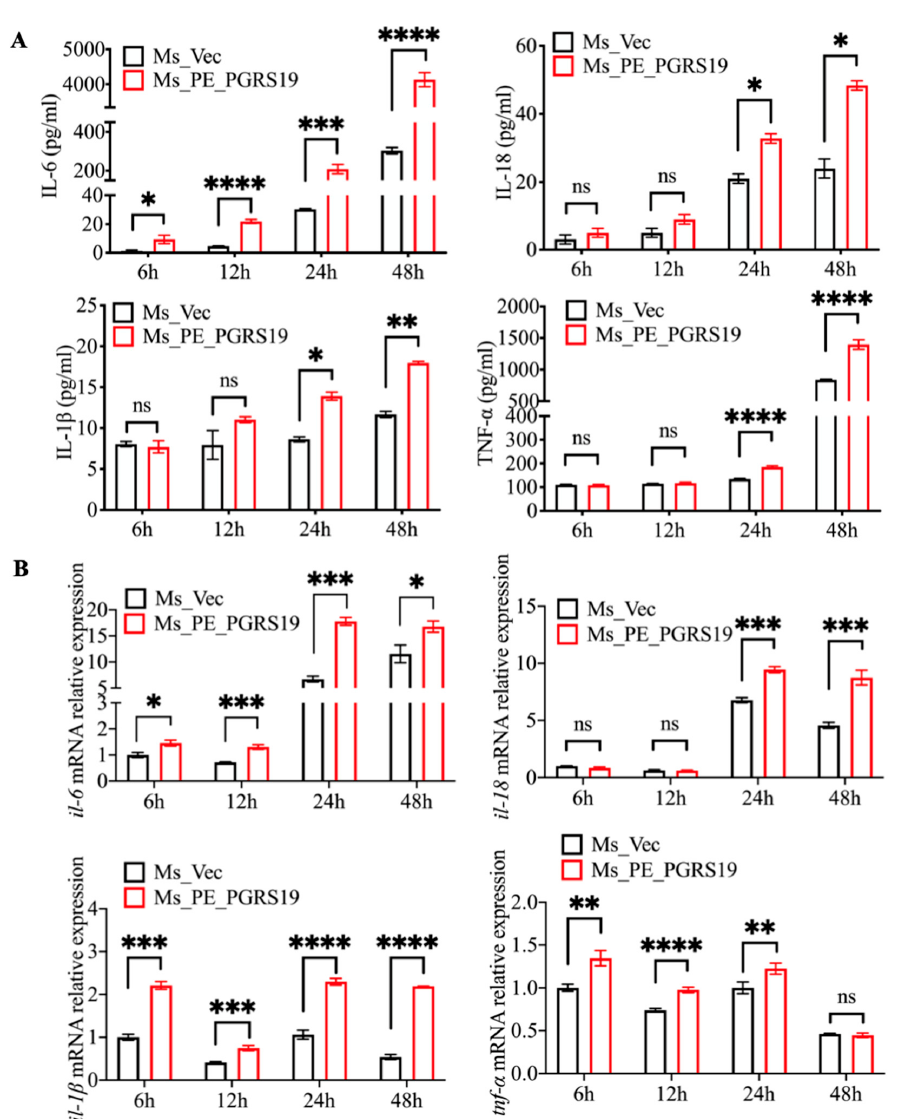
Figure 3. Cell cytokine expression and secretion in macrophages infected with the recombinant strains. Secretion ( A ) and mRNA relative expression ( B ) of TNF- α , IL-6, IL-1 β , and IL-18 were measured by ELISA assay and real-time PCR in Ms_PE_PGRS19- and Ms_Vec-infected J774A.1 cells at 6, 12, 24 and 48 h. Data are presented as x ̄ ± SD of three independent experiments. ns p > 0.05, * p < 0.05, ** p < 0.01, *** p < 0.001, **** p < 0.0001. 3.4. PE_PGRS19 Induces Cell Pyroptosis by Promoting the Cleavage of Caspase-11 and GSDMD Ms_PE_PGRS19 infection increased LDH and pro-inflammatory cytokine release in macrophages, indicating that it could promote cell damage and cell death. To define the kind of cell death caused by Ms_PE_PGRS19 infection, J774A.1 cells were infected with Ms_PE_PGRS19 and Ms_Vec and stained with annexin V-PI; then, they were collected and subjected to flow cytometry analysis. The fluorescence-activated cell sorting (FACS) results showed an increase in PI + /annexin + cells (Figure 4A) and a sharp decrease in PI -